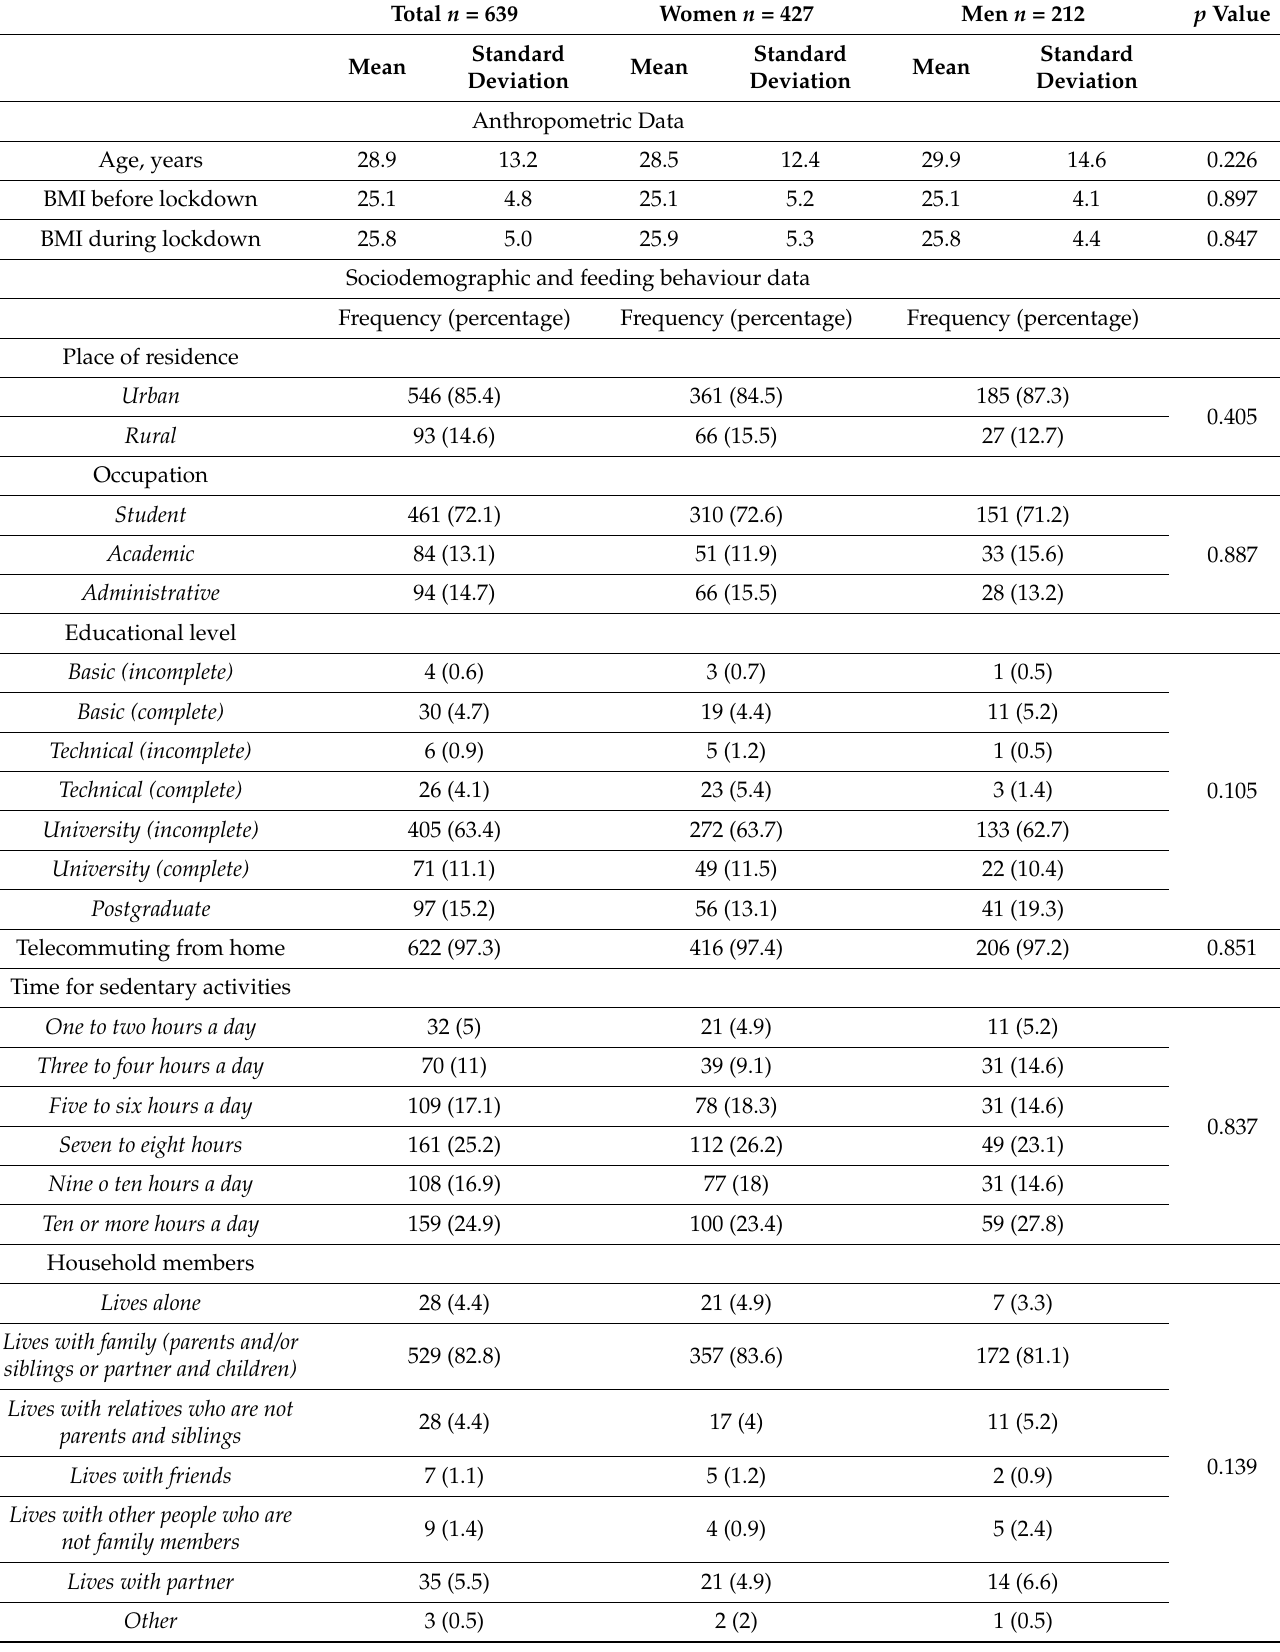
Table 1. Descriptive characteristics of the population, disaggregated by